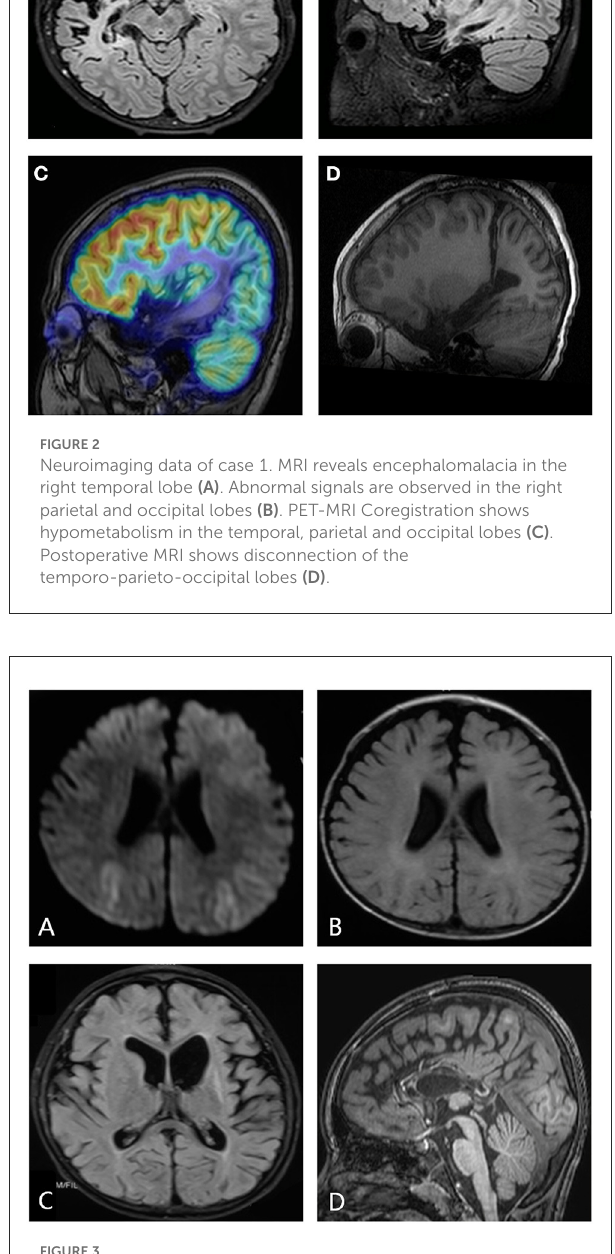
interictal and ictal EEG. These patients all underwent different surgical approaches, and the prognoses were different. The surgical strategies were mainly based on neuroimaging data.